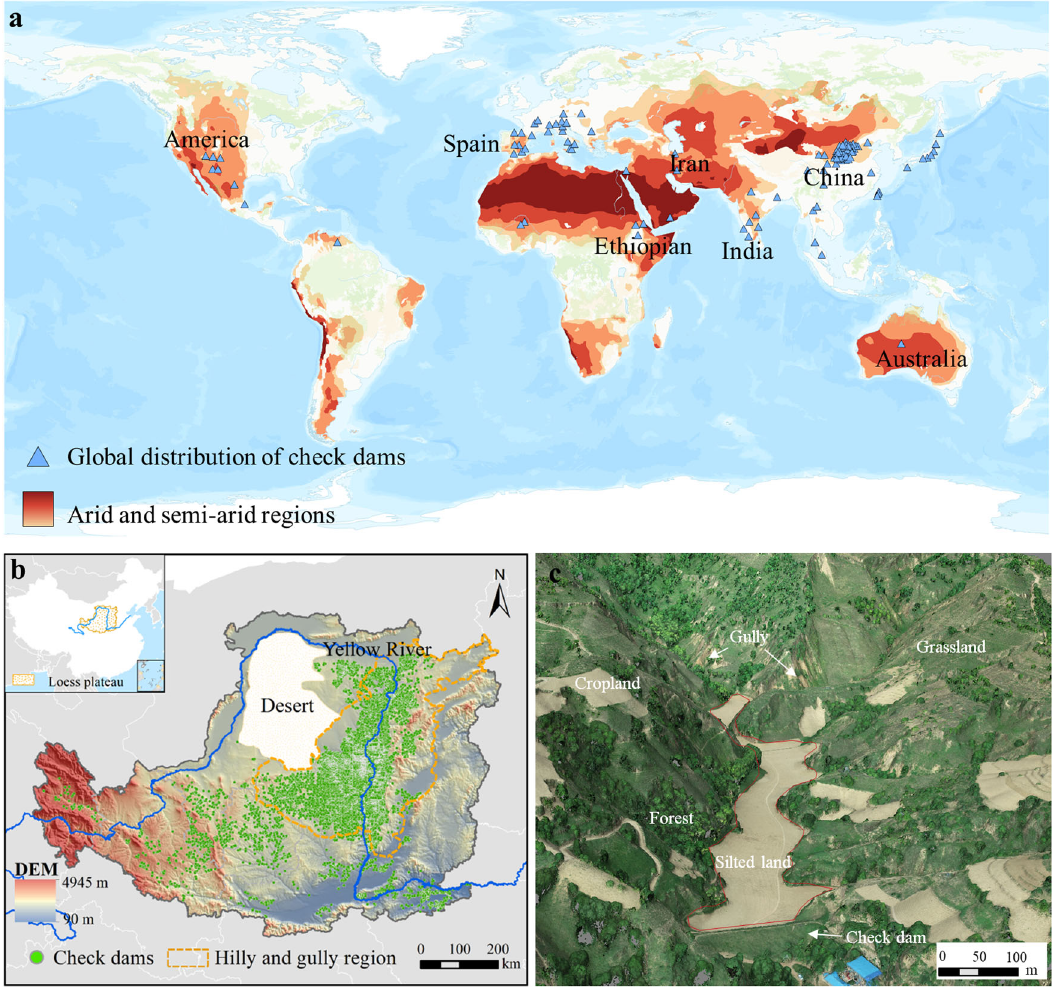
Fig. 1 Check dams in the world and the Chinese Loess Plateau. a Distribution of check dams in the world 16 (the blue triangle only represents the approximate spatial distribution of check dams around the world, not the actual number). b Distribution of check dams on the Chinese Loess Plateau. c Image of a typical silted land and check